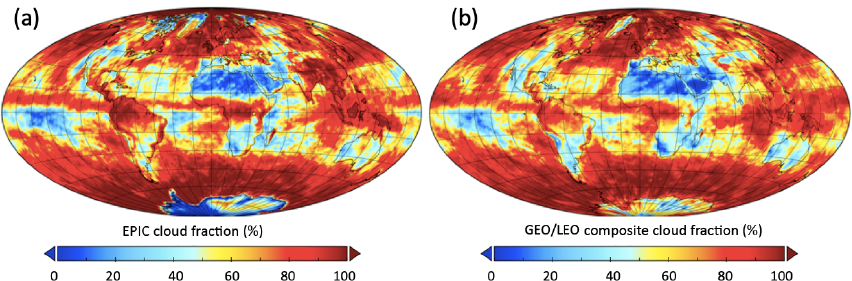
Figure 7. Comparison between EPIC global cloud coverage and co-located (spatially co-located and time difference within 5min) GEO– LEO results. Four weeks of data from 2016 are utilized with 1 week from each season (6–12 March, 20–26 June, 21–27 September, and